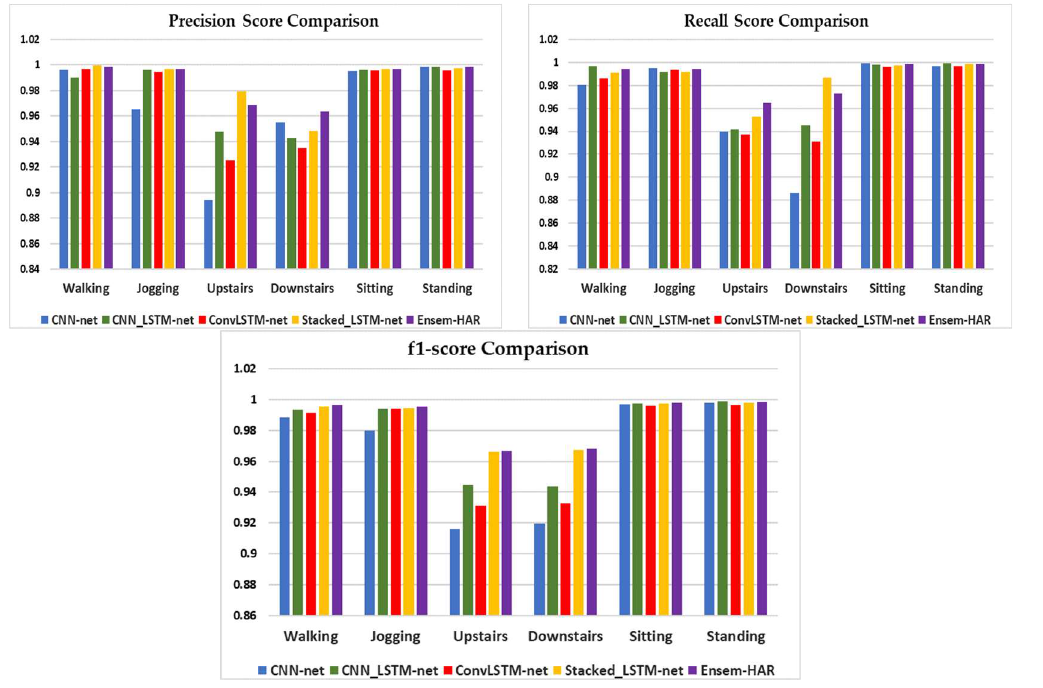
Figure 12. Visual comparison of performances for each activity class in respect of Precision, Recall and F1-score between ‘CNN-net’, ‘CNN-LSTM-net’, ‘ConvLSTM-net’, ‘StackedLSTM-net’, and ‘Ensem-HAR’ models on WISDM dataset.